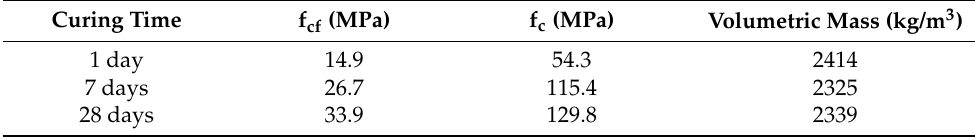
Table 9. Properties of UHPSFRC, mixture